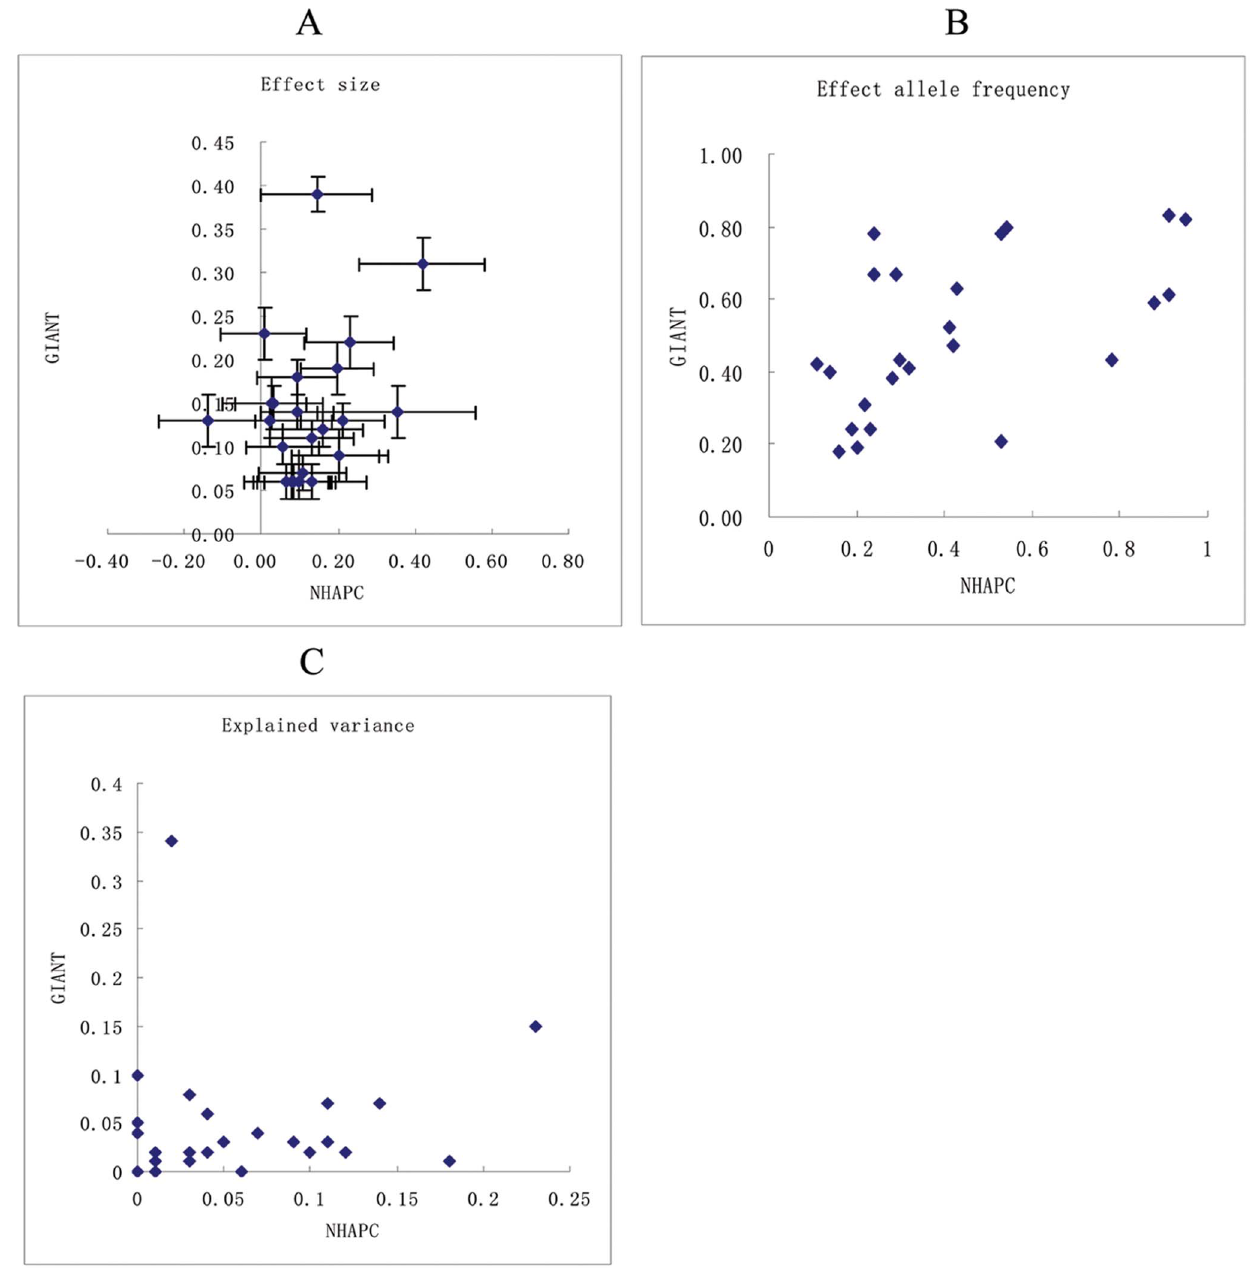
Figure 1. Correlation of BMI-related loci between European ancestry and Chinese Hans. The plots showed the effect size (kg/m 2 ) of loci on BMI (A), BMI-increasing allele frequencies (B), and explained variance (%) of loci on BMI (C) in GIANT (Speliotes et al) and NHAPC (our data) studies. X-axis represents the data from our study (NHAPC) and Y-axis represents the data from European ancestry populations (GIANT).